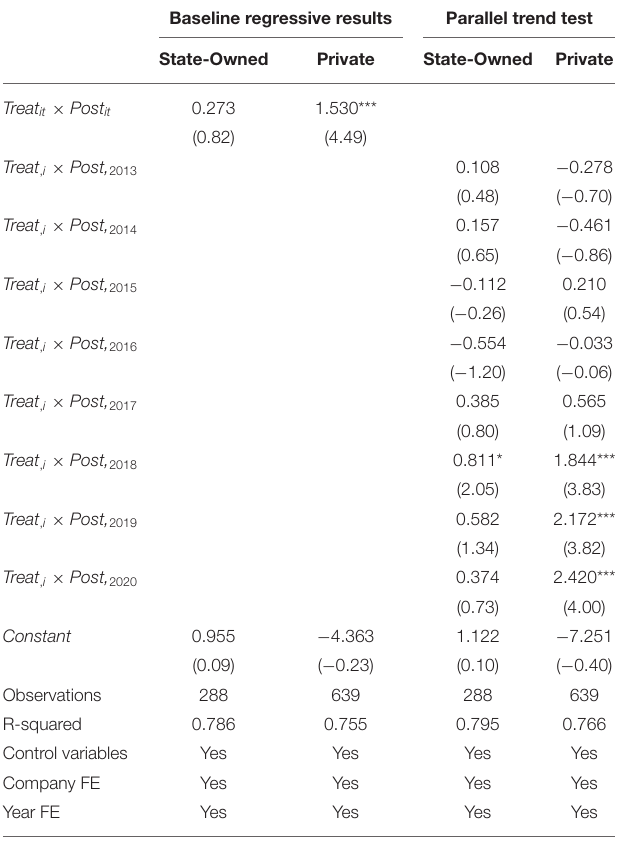
TABLE 6 | Results of the operating nature heterogeneity